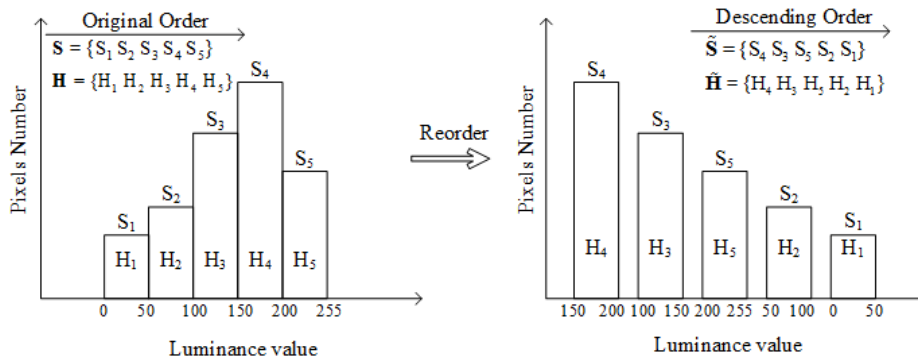
Figure 5. The histogram of pixels luminance values and the reordered histogram.